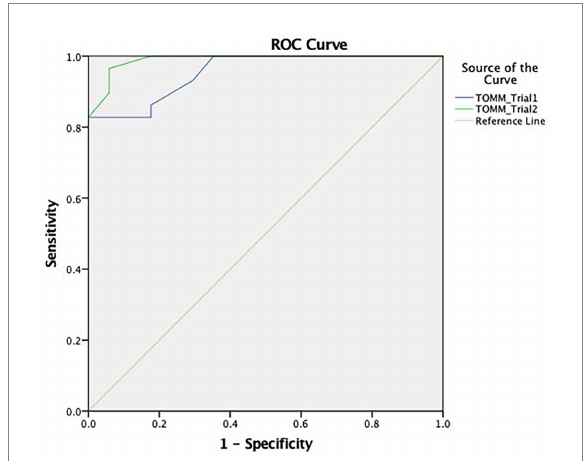
FIGURE 2 ROC curve concerning the discriminative capacity of the Test of Memory Malingering (TOMM).